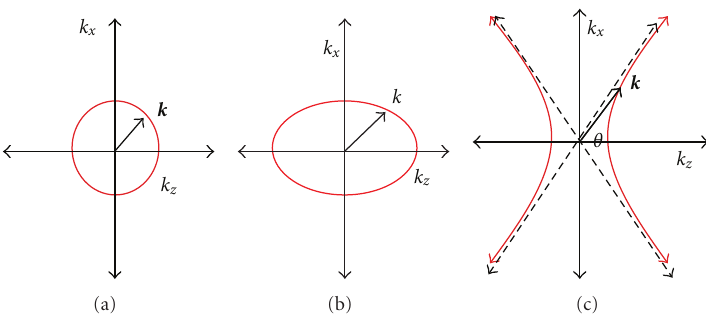
Figure 1: (a) Equifrequency surface diagram for an isotropic medium ( ε z = ε x ). (b) Equifrequency surface diagram for an anisotropic medium ( ε z / = ε x ). (c) Equifrequency surface diagram for an indefinite medium (hyperbolic) with ( ε z < 0, ε x > 0).